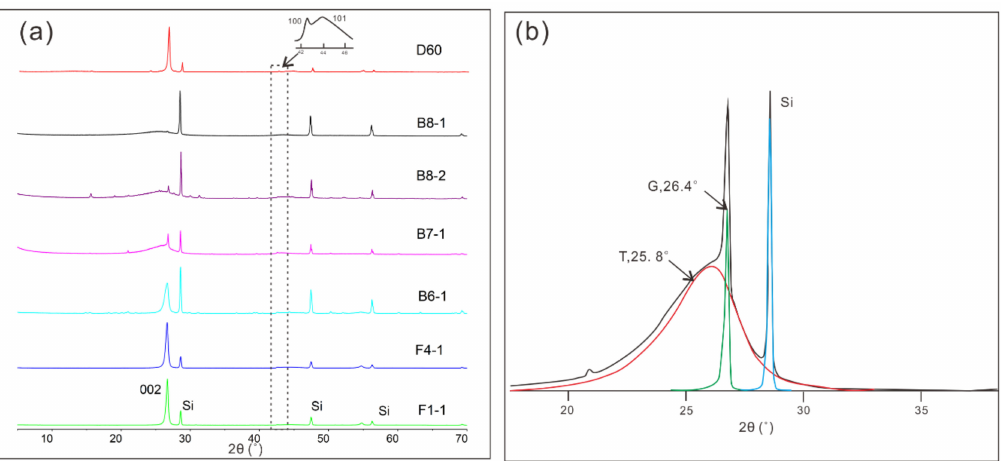
Figure 2. ( a ) XRD profiles of representative samples with increasing distance from the intrusion. ( b ) Sample B7-1 had a (002) peak fitted into two separate peaks at 26.4 ◦ and 25.8 ◦ , signifying a crystalline structure and a turbostratic structure. Table 2. XRD parameters and optical reflectance of